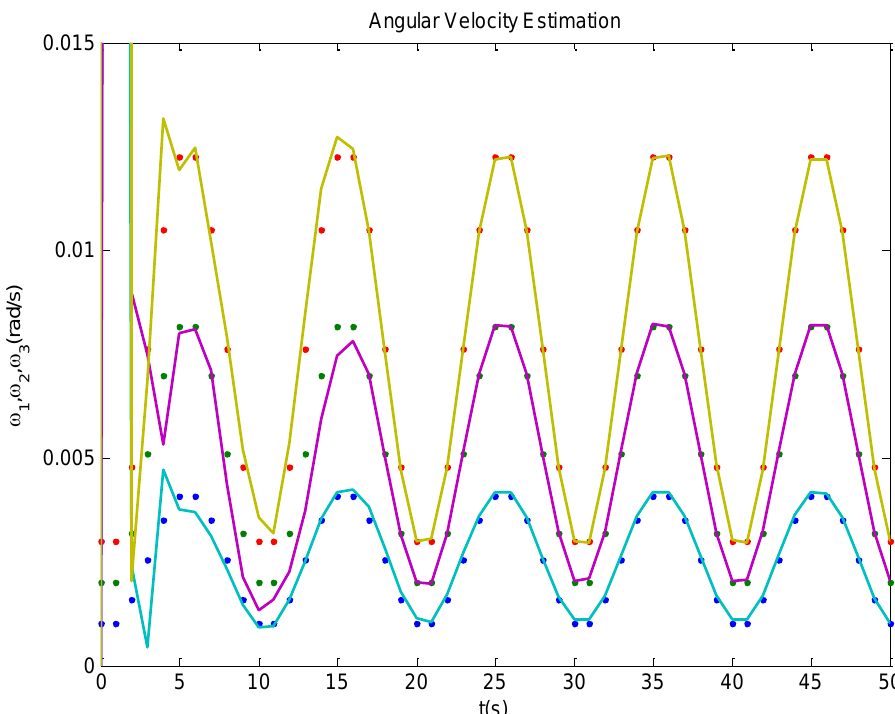
Figure 3. Real (dots) and estimated (solid) angular velocities in a simulated case, where a Kalman filter observer based on modified –observable– model was used. The filter now is able to correctly estimate the velocity components, since the model used is observable.